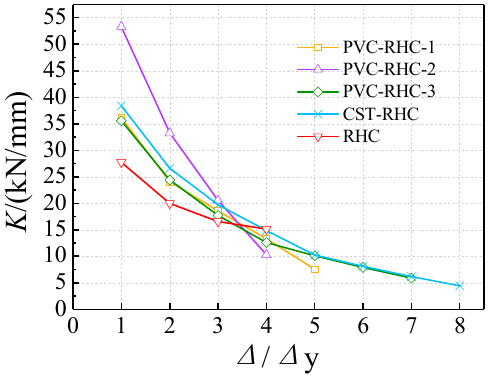
Figure 13. Stiffness degradation curves. Figure 13. Sti ff ness degradation